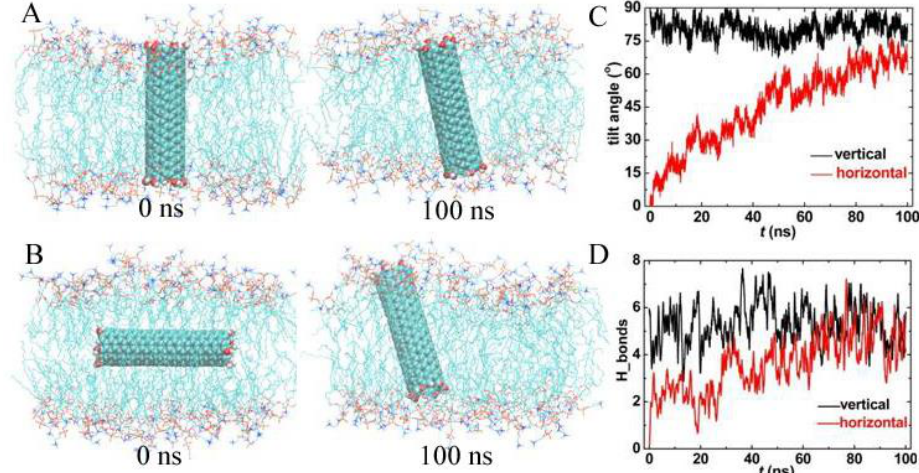
Figure 4. Trajectories of functionalized carbon nanotubes (FCNT) located in the membrane vertically and horizontally. ( A , B ) Snapshots at t = 0 ns and 100 ns, ( C ) the tilt angle, and ( D ) the hydrogen bonds between FCNT and lipid bilayer.